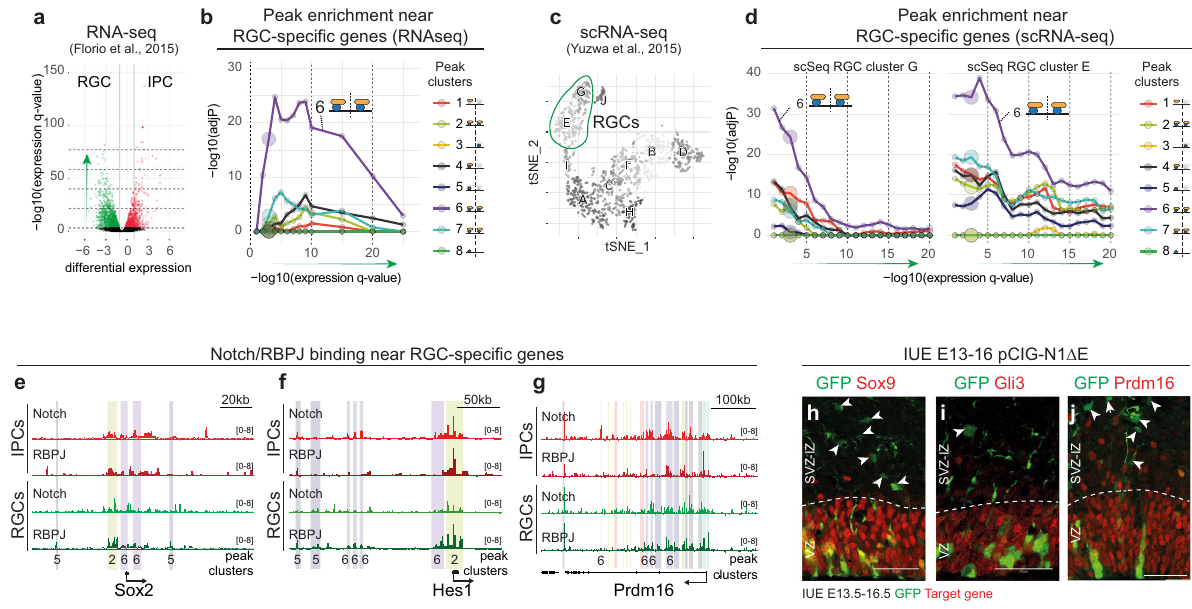
Fig. 4 Ectopic NICD can bind to RGC-speci fi c genes during differentiation. a – d Bulk RNA-seq 34 a and single-cell RNA-seq 35 c of RGCs and IPCs. Enrichment of NOTCH/RBPJ peak clusters b , d near genes differentially expressed in RGCs as compared to IPCs. e , f , g NOTCH and RBPJ binding pro fi les in RGCs and IPCs near RGC-speci fi c genes. Peak loci and corresponding peak cluster (coloured shading corresponds to clusters in Fig. 3) shown. h – j IUE of pCIG-N1 Δ ECD stained for GFP (green) and the indicated RGC-speci fi c NOTCH/RBPJ target gene ( Sox9 , Gli3 , Prdm16 ; red; n = 1). Arrowheads indicate differentiating electroporated cells in the SVZ/IZ. Scale bars 50 µ